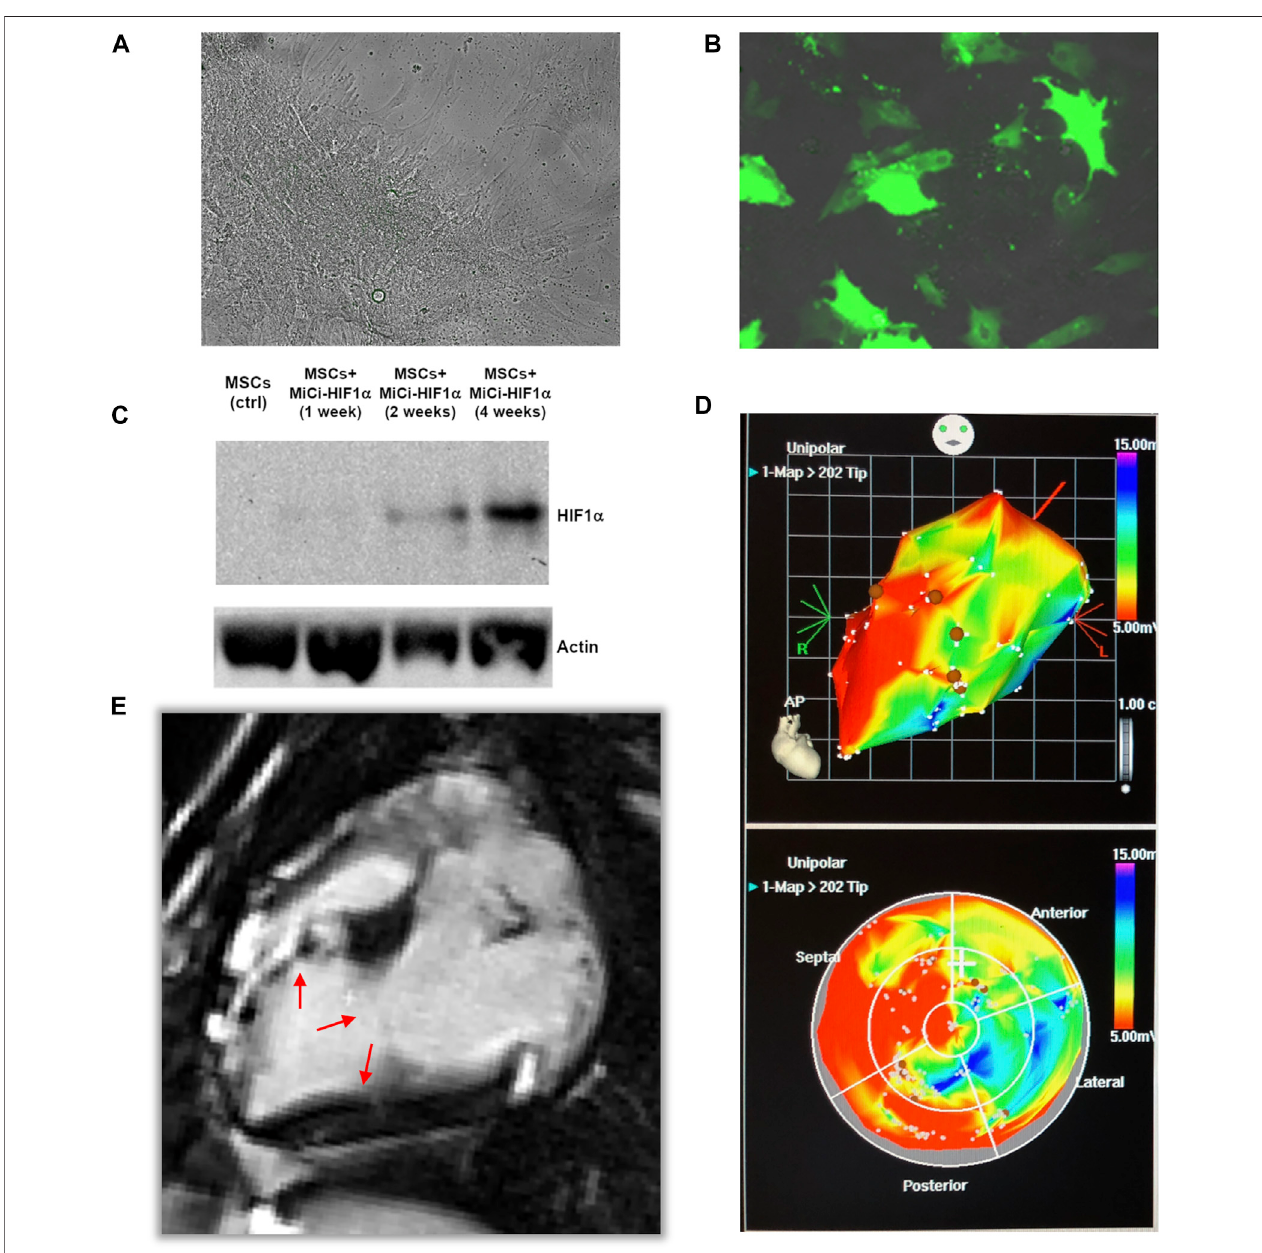
FIGURE 2 | Minicircle-HIF1 α transfection in pig mesenchymal stem cell. (A) Representative bright fi eld picture of pig mesenchymal stem cell culture (MSC) before transfection of minicircle-HIF1 α (MiCi-HIF1 α ). (B) Representative fi gure of transfected MSC culture, labelled with MiCi-HIF1 α -green fl uorescence protein 4 weeks after transfection. (C) Western blot showed gradually increased HIF1 α protein expression in cell culture lysates (molecular weight 120 KDa) one, 2, and four weeks after the initial of two transfections. (D) 3D (upper) and 2D (bottom) NOGA electro-anatomical mapping and 3D-guided percutaneous intramyocardial injections (brown points). (E) Representative fcMRI (late-gadolinium enhancement) image 2 months after AMI and 1 month after cell injections. Arrows show the infarct border